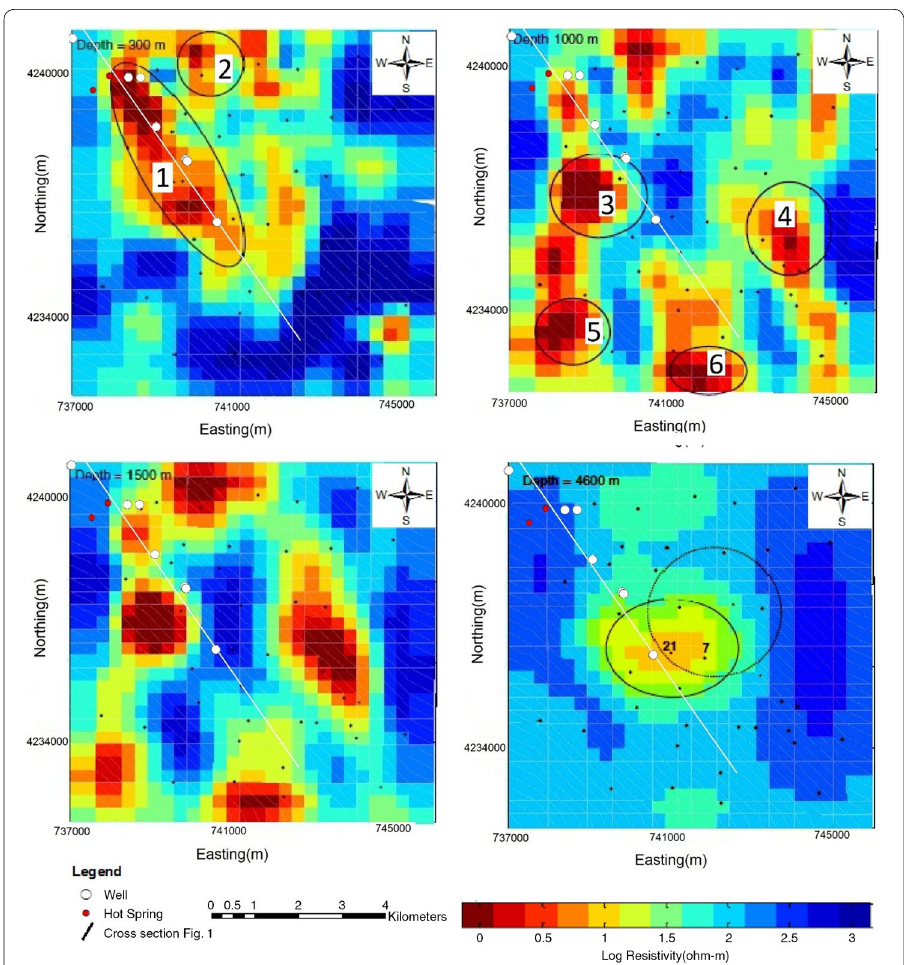
Fig. 4 The resistivity slices at different depths (modified from Ghaedrahmati et al. 2013), the black dots on maps show MT stations and the labels 1 , 2 , 3 , 4 , 5 and 6 display conductive (anomaly) zones related to geo‑ thermal resource obtained from 3‑D modelling results. New location of the hotter zone (as an ellipse ) and its previously identified location by EDC (2010) (as a circle ) are also illustrated on the 4600 m depth slice